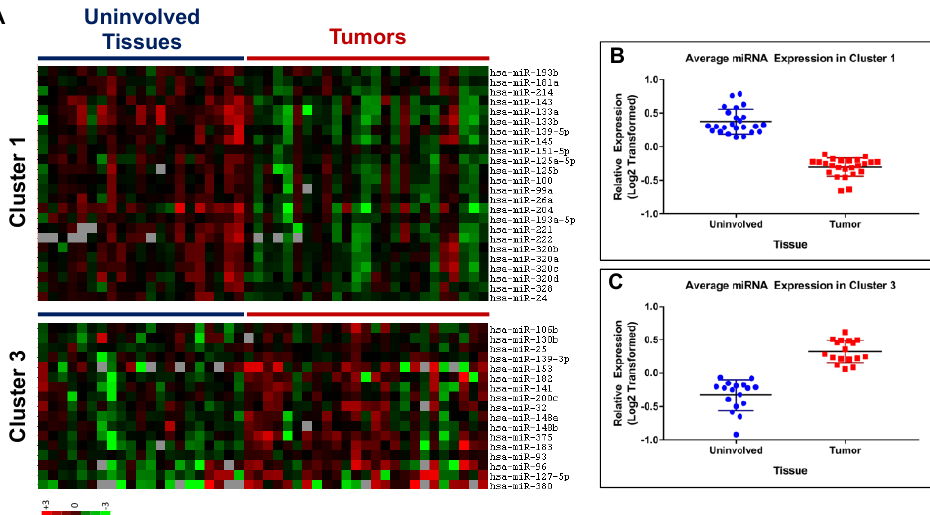
Figure 2. Analysis of clusters 1 and 3 identified from miRNA profiling of prostate tissues. ( A ) Heat maps of expression data for miRNAs in clusters 1 and 3; uninvolved tissue samples grouped under the blue line (left side) and tumor samples grouped under the red line (right side). ( B , C ) The average expression value of each miRNA was calculated for uninvolved tissue samples (blue circles) and tumor samples (red squares). These values were used to generate dot plots for cluster 1 ( B ) ( p = 4.83 × 10 −18 ) and cluster 3 ( C ) ( p = 1.70 × 10 −10 ).